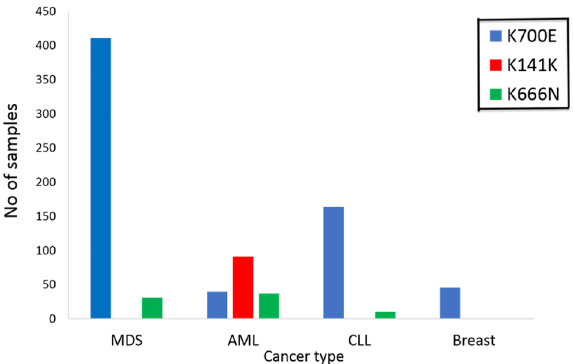
Figure 3. A clustered bar chart shows the number of hematologic and breast cancer patients who had any of these mutations p.K700E, p.K141K, and p.K666N, these are colored in blue, red, and green,